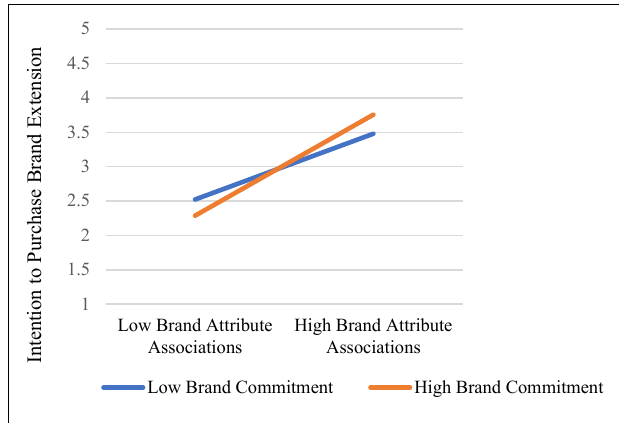
FIGURE 4 | Moderating effects of BC.